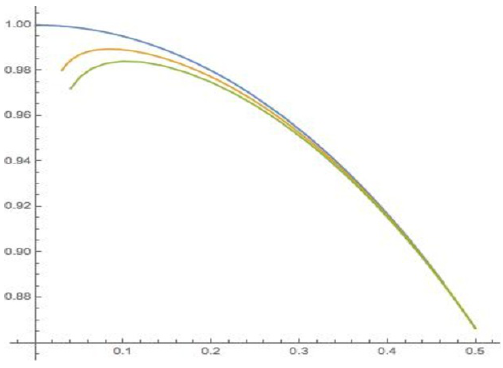
Figure 3 . Trajectories of the in(cid:13)aton for di(cid:11)erent initial conditions with e-fold numbers N (cid:3) in the interval [50 ;